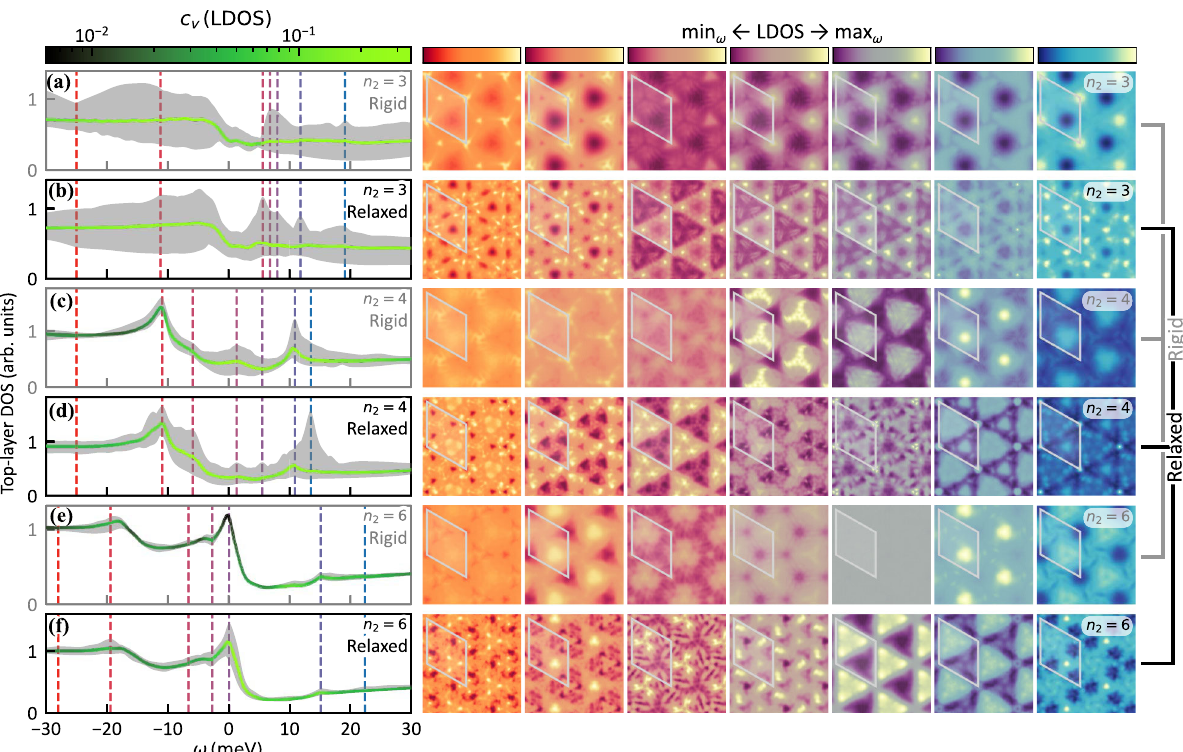
FIG. 9. Small-angle ( θ ¼ 0 . 1 °) electronic structure of few-layer graphene on graphite. The number of layers of the first graphite flake is set to n 1 ¼ 20 , whereas the number of layers of the second graphite flake is varied from n 2 ¼ 3 (a),(b) over n 2 ¼ 4 (c),(d) to n 2 ¼ 6 (e),(f). In panels (rows) (a),(c),(e) we use rigid atomic positions and in (b),(d),(f) relaxed ones. The color of the lines in the left subpanels codes the coefficient of the variation of the top-layer LDOS, with green as nonuniform regions and black as uniform regions. The gray background is given by the minimum and maximum values of the LDOS. On the right, we show LDOS maps at selected frequencies indicated in the left subpanels. Each subsequent two rows [e.g., (a) and (b)] share a color map for each frequency such that differences in relaxed and rigid structures are